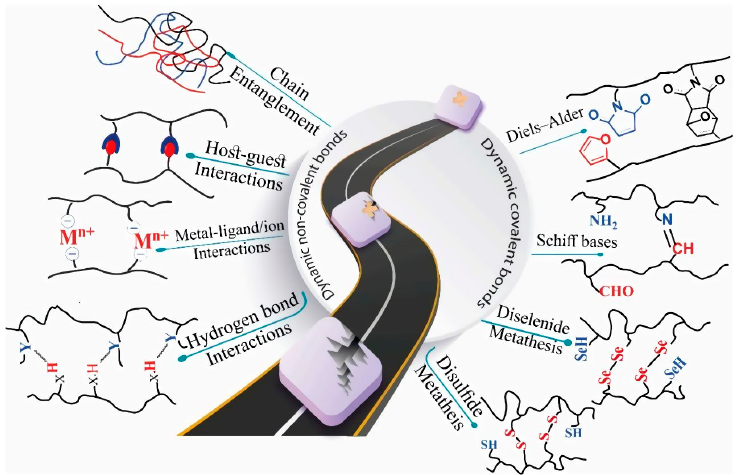
Figure 6. Schematic of dynamic covalent and no-covalent bond operation in the self-healing process. Reprinted with permission from Ref. [102].